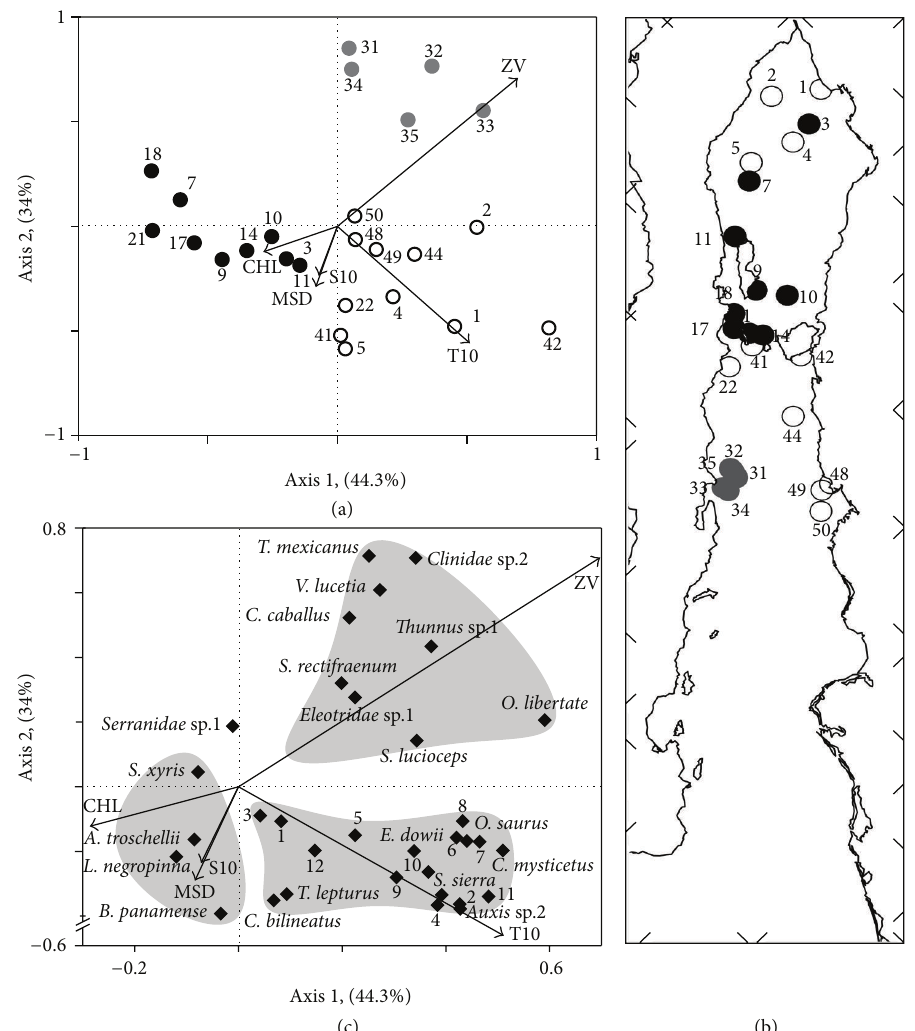
Figure 8: Classification and ordination analysis: July. (a) RDA biplot of sampling stations environment, black circles = JuG1; grey circles = JuG2; open circles = JuG3. (b) Distribution of stations groups resulting from RDA. (c) RDA biplot species environment. 1 = Bregmaceros bathymaster , 2 = Balistes polylepis , 3 = Epinephelus sp. 1, 4 = Gobiidae sp. 2, 5 = Gobiidae sp. 3, 6 = Ophichthus zophochir ; 7 = Sciaenidae sp. 1, 8 = Sciaenidae sp. 2, 9 = Scorpaena guttata , 10 = Syacium ovale , 11 = Symphurus williamsi , 12 = Angiliforme sp.